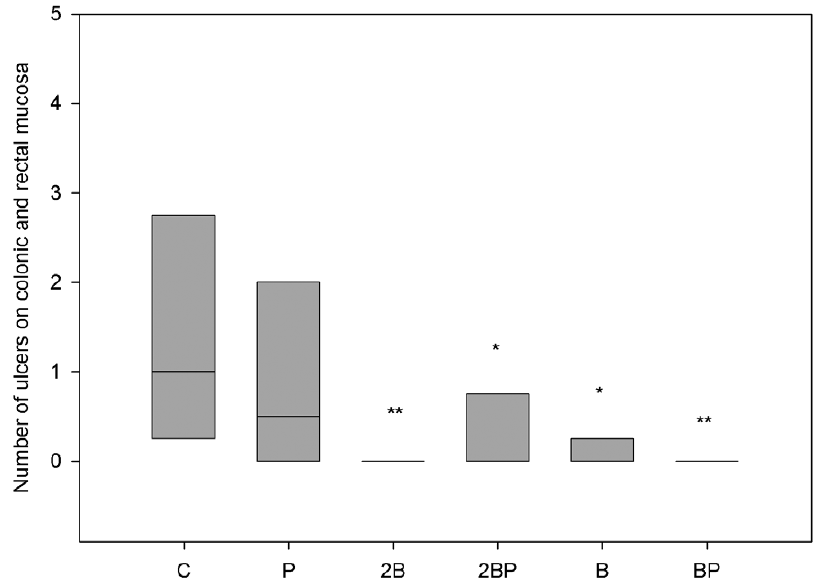
Figure 6. Quantification of colonic and rectal ulcers. Number of ulcers of colonic and rectal mucosa in different treatment groups. ** denotes P # 0.01 and * denotes P , 0.05 compared to group C.